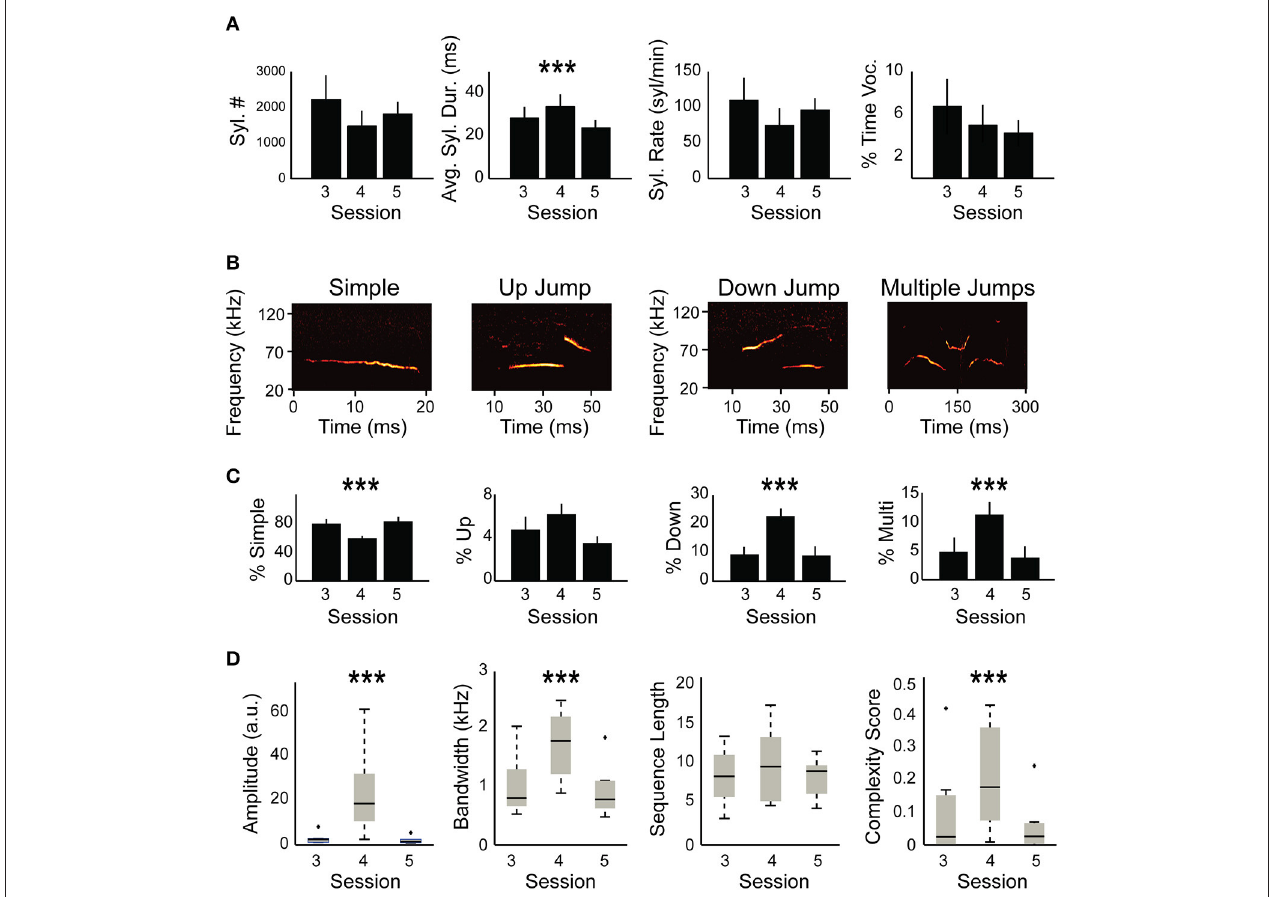
FIGURE 2 | Syllable composition is different between non-restrained and head-restrained sessions. (A) Quantification of USVs including: total number of syllables, syllable duration, syllable rate, and fraction of time during USVs of the total session (in %). The averages of these parameters are compared between the head-fixed session (S4) and the session before (S3) and the session after (S5). Only average syllable duration was longer due to head restraint ( p = 0.0005). (B) Spectrogram example from each syllable category including “simple,” “down,” “up,” and “multiple.” (C) Distribution of syllable types between the different sessions. A decrease in “simple” syllables in the head-restrained session (S4, p < 0.0001) is accompanied by an increase in “down jump” and “multiple jump” syllables ( p < 0.0001) and “multiple jumps” syllables ( p = 0.0003) while no change occurred in “up jump” syllables ( p = 0.058). (D) Amplitude ( p < 0.0001), bandwidth ( p < 0.0001) and complexity ( p = 0.0005) were affected by head restraint whereas sequence length ( p = 0.12) did not show any significant differences. *** p <